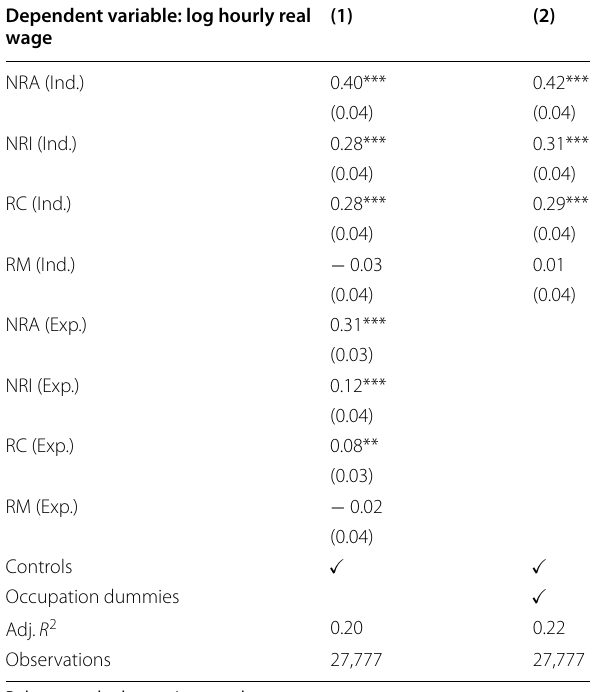
Table 13 Task measures as wage predictors: narrow task